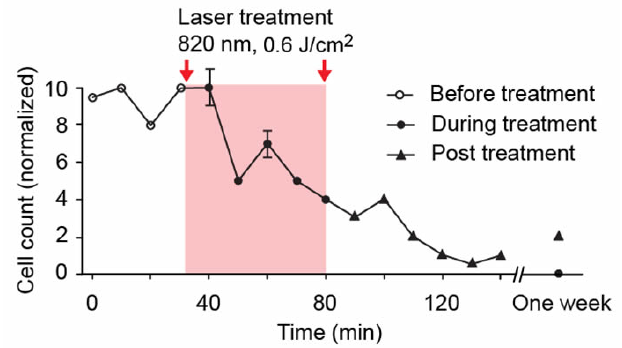
Figure 14. Theranostic of melanoma CTCs integrating PA detection, PT killing, and PA assessment of therapeutic efficacy through a decrease in the CTC count